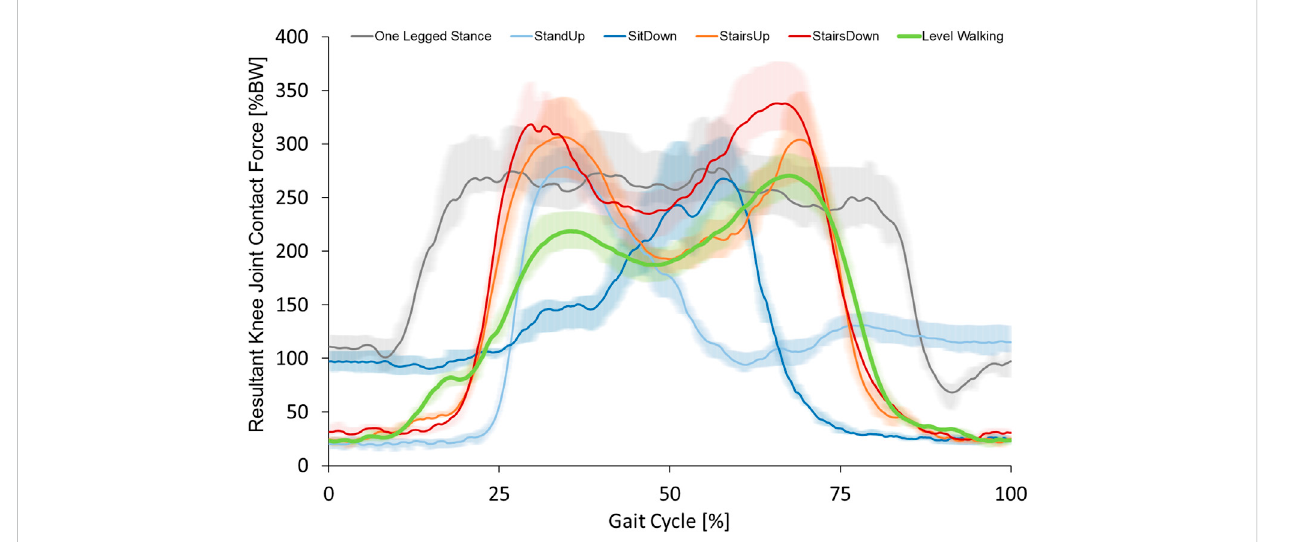
FIGURE 2 Averaged in vivo measured joint load patterns at the knee, during activities of daily